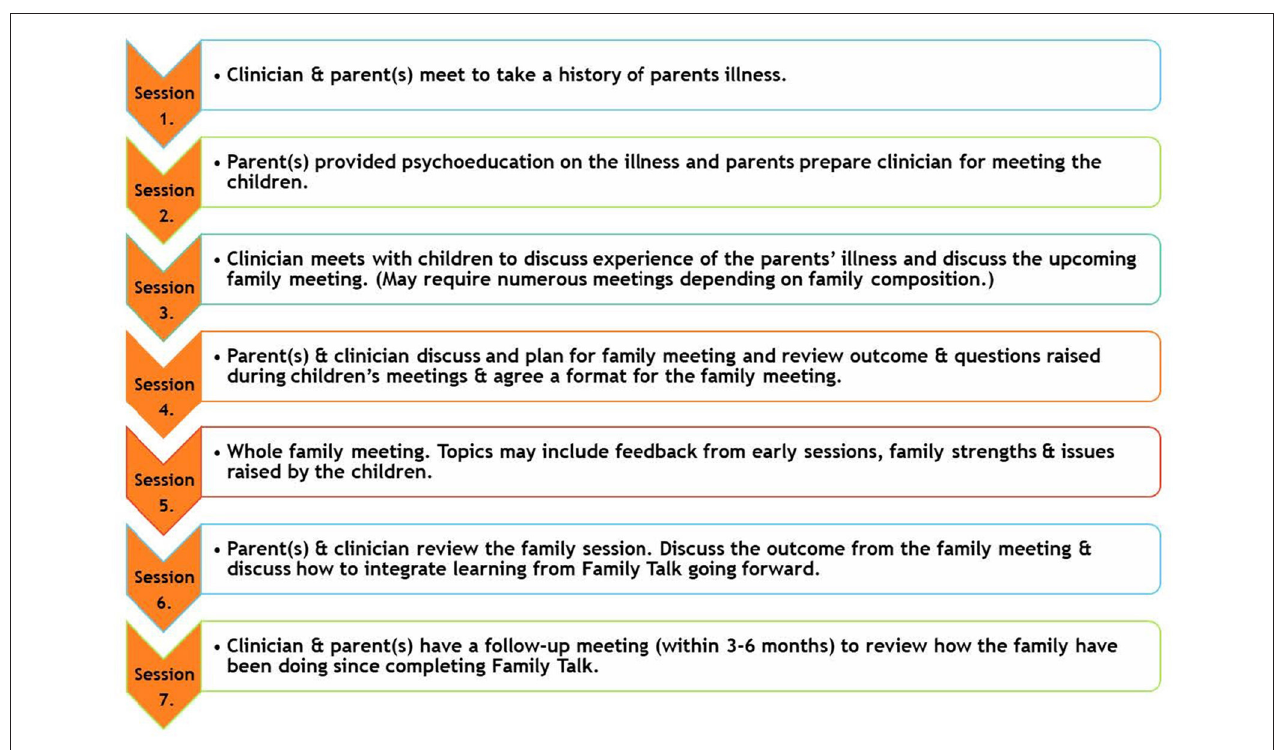
FIGURE 1 | Family Talk